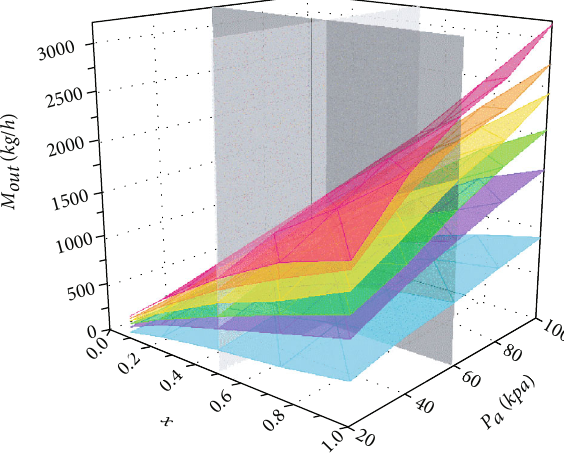
Figure 14: Relation of mass fl ow rate M opening x and ambient pressure P a .